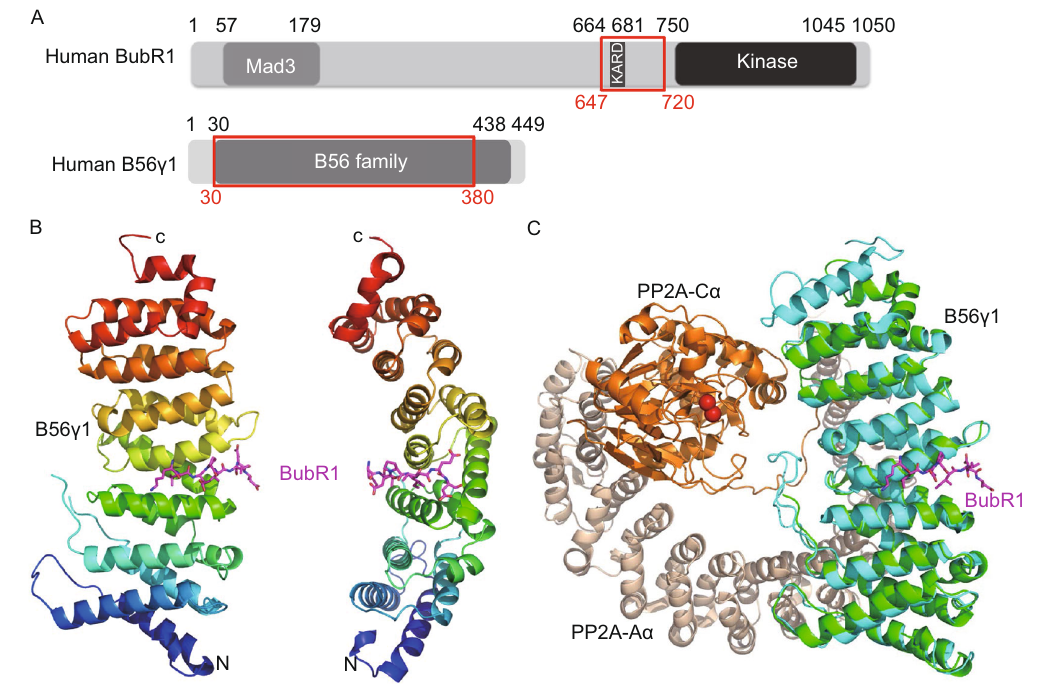
Figure 1. Overall structure of the B56-BubR1 complex. (A) Schematic representations of domain structures of human BubR1 and PP2A B56 γ 1 proteins. Numbers above indicate amino acid position based on the sequence of human BubR1 and B56 γ 1. The fragments used for crystallization are indicated by red boxes. (B) Overall structure of the B56 γ 1(30 – 380)/BubR1(647 – 720)-3D complex, in two orthogonal views. (C) Superposition of the B56 γ 1-BubR1 structure with that of the A α -B56 γ 1-C α PP2A holoenzyme (PDB code: 2IAE). The red spheres are the two Mn 2+ ions in the PP2A active